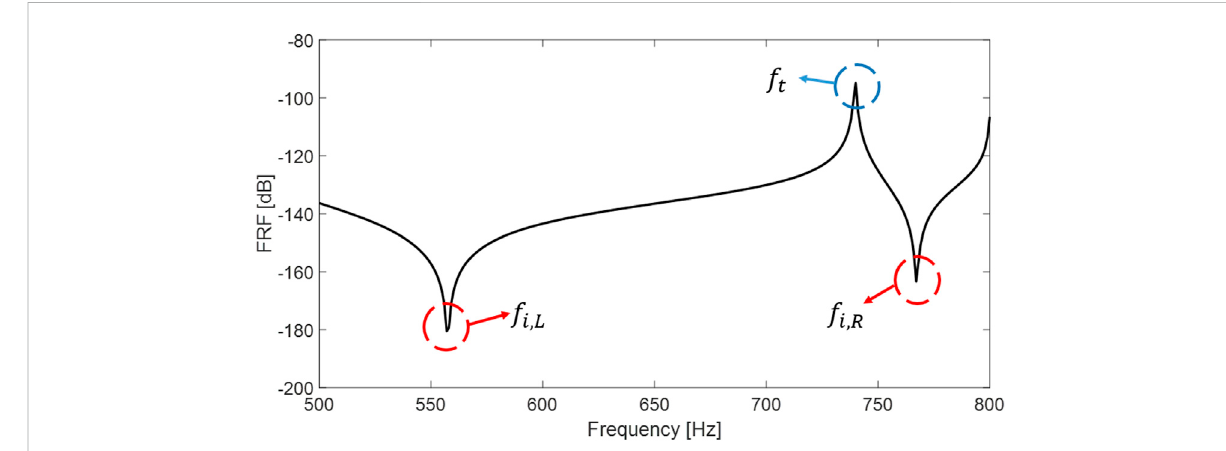
FIGURE 3 Example to show the left and right anti-resonance frequencies f i , L and f i , R near a target mode f t .